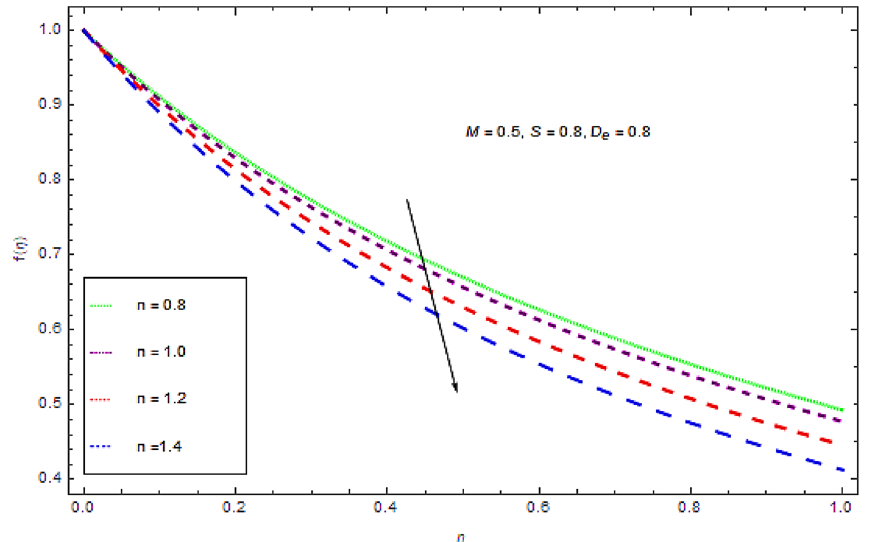
Figure 4. Impression of n on f (η) .